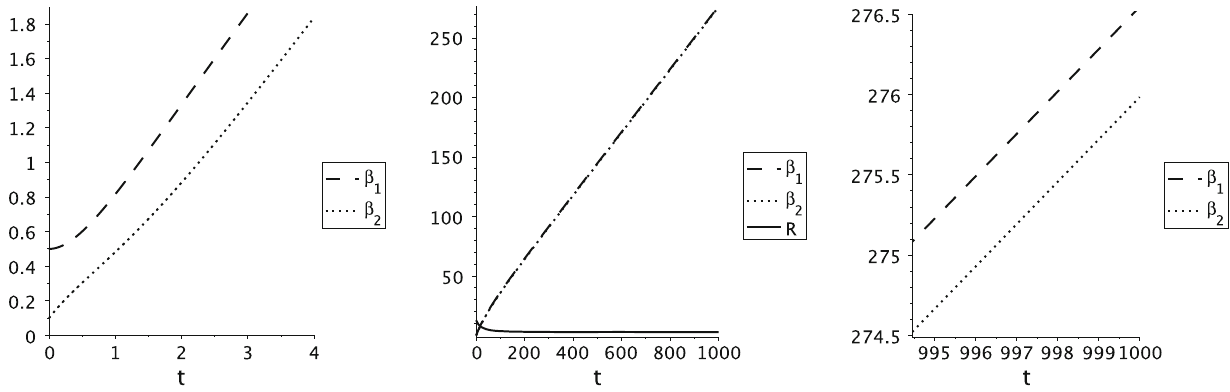
Fig. 1 Numerical solution to system of Eqs. (4), (5) and (7) for initial conditions β 1 ( 0 ) = 0 . 5 , β 2 ( 0 ) = 0 . 1 , ˙ β 1 ( 0 ) = 0 , ˙ β 2 ( 0 ) = 0 . 5 , ˙ R ( 0 ) = 0. R ( 0 ) (cid:4) 12 . 6745229 is found from Eq. (8). For the found numerical solution H 1 = H 2 (cid:4) 0 . 263569, R 0 (cid:4) 2 . 917699